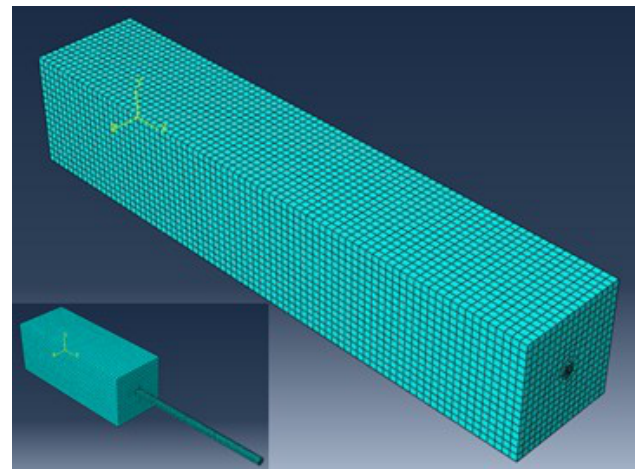
Figure 5. Mesh used for the tension stiffening